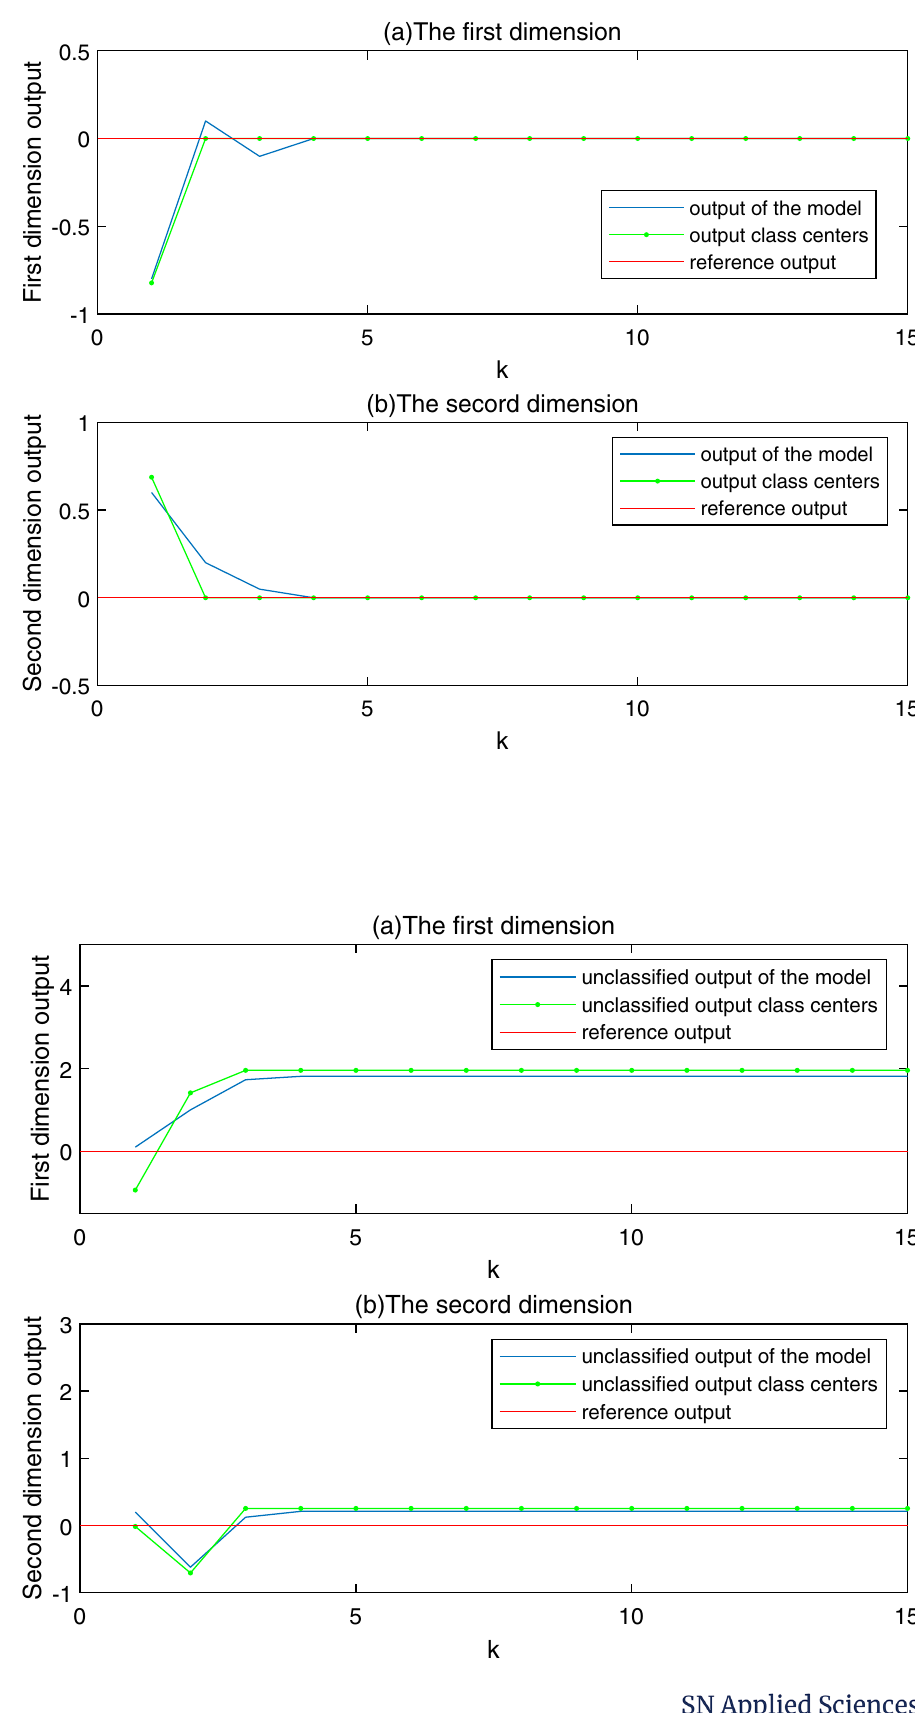
Fig. 8 System output curves of burning processes